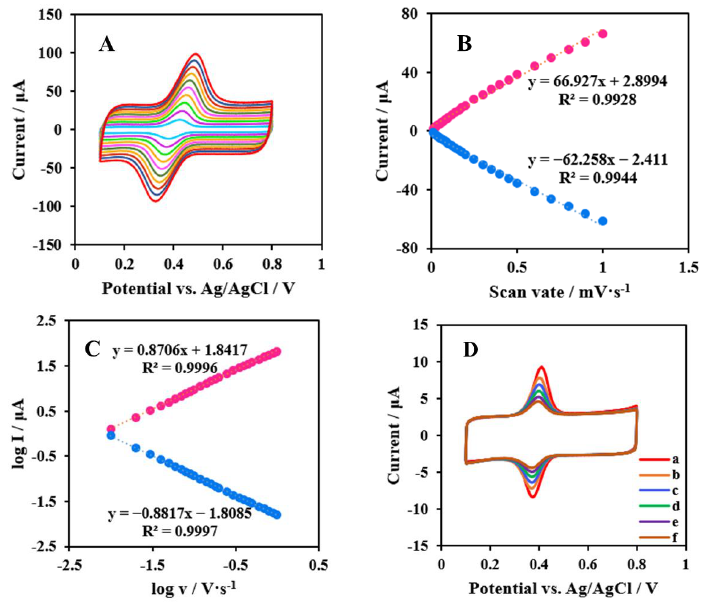
Figure 5. ( A ) CVs of NF/IL/CMC-MWCNTs/GCE in 50 mM pH 5 PBS containing 5 μM rutin at different scan rates (from inner to outer: 0.1, 0.2, 0.3, 0.4, 0.5, 0.6, 0.7, 0.8, 0.9, and 1 V ꞏ s −1 , respectively). ( B ) Plot of peak current vs. scan rate. ( C ) The relationship between log v and log I. ( D ) CVs of NF/IL/CMC-MWCNTs/GCE in the presence of 5 μM rutin (a) and in the absence of rutin after different scanning cycles: 20 cycles (b), 40 cycles (c), 60 cycles (d), 80 cycles (e), and 100 cycles (f).